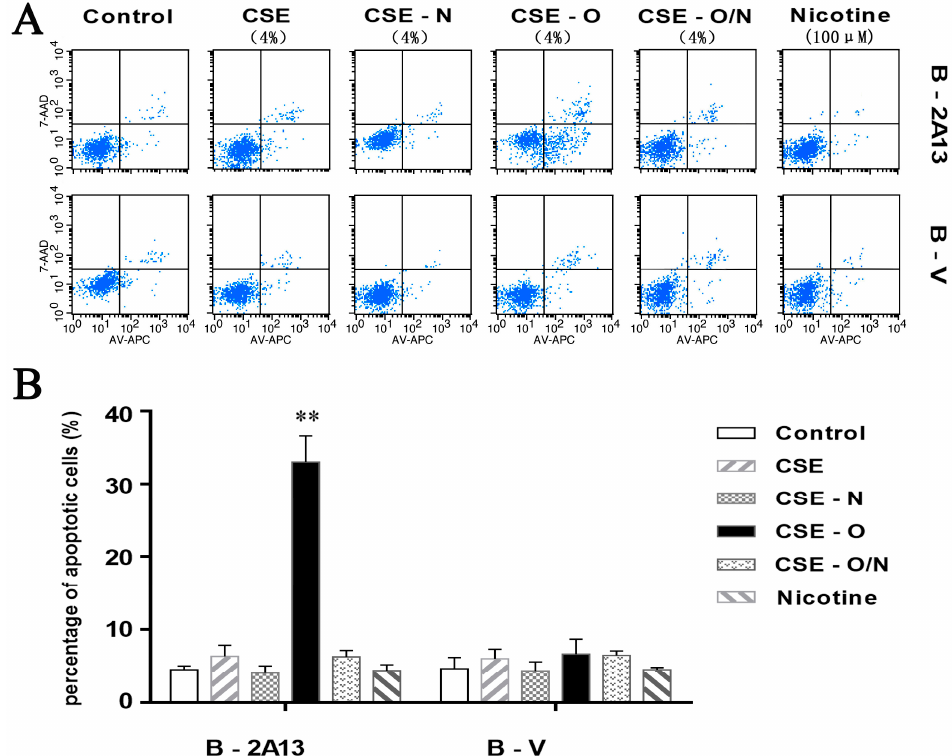
Figure 4. Cellular apoptosis of immortalized human bronchial epithelial (BEAS ‐ 2B) cells treated with cigarette smoke extract (CSE), nicotine section of CSE (CSE ‐ N), and nicotine ‐ free section of CSE (CSE ‐ O). The cells were treated with 4% CSE, CSE ‐ N, CSE ‐ O, CSE ‐ O/N, or nicotine standard for 24 h, and a flow cytometry assay was used to determine cellular apoptosis. ( A ) Spectrum, and ( B ) statistical data. The percentage of apoptotic cells is presented as the mean ± SD of three independent experiments with triplicate samples. ** p < 0.01, compared to cells treated with CSE or CSE ‐ N.